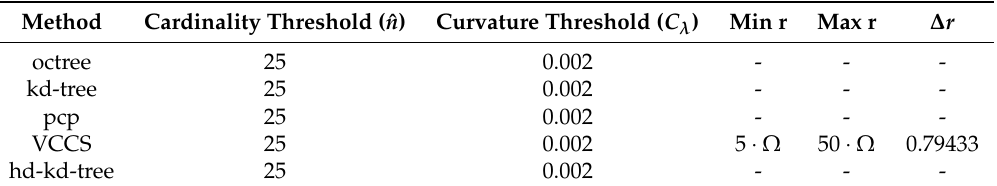
Table 3. Setup for partition methods